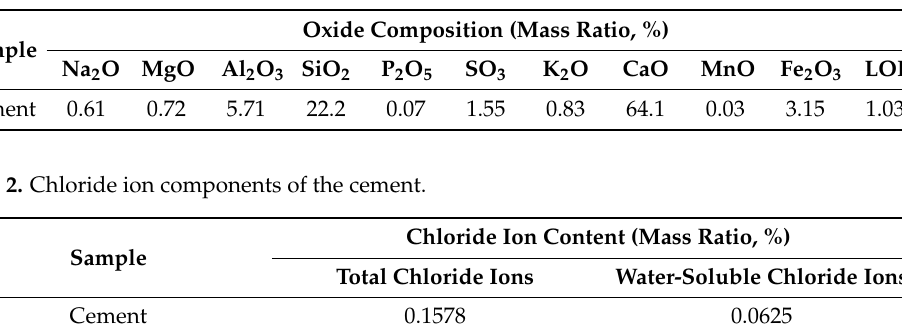
Table 1. Chemical composition of the cement.